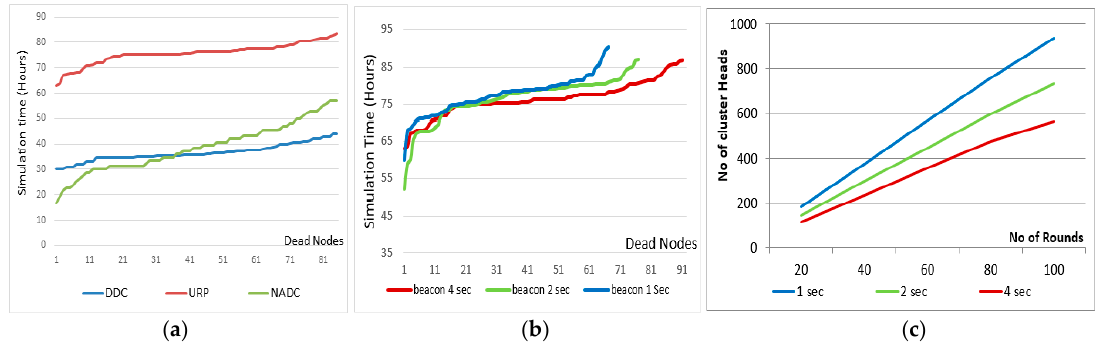
Figure 10. Simulation results of different cases ( a ) Number of dead nodes vs. simulation time ( b ) effect of varying beacon sending period.